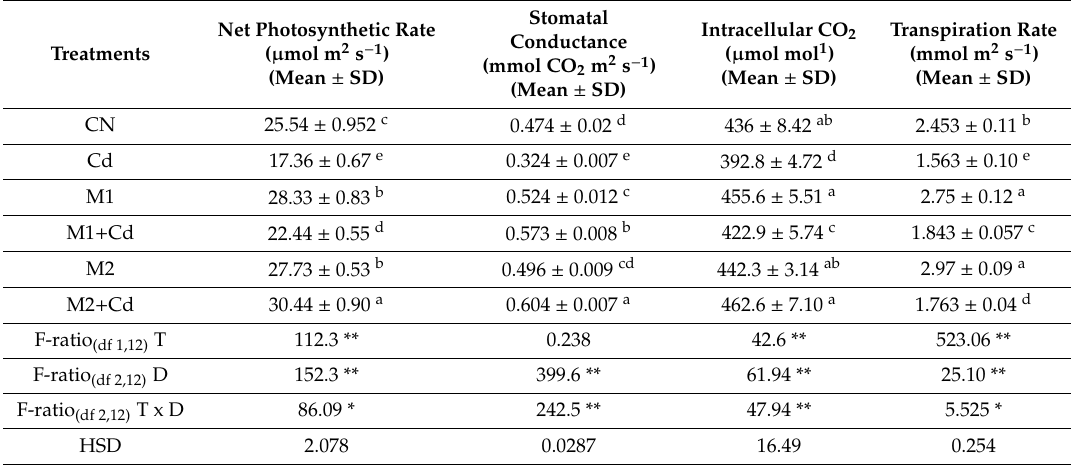
Table 1. E ff ect of Cd (0.4 mM), M1 (10 9 cells / mL), and M2 (10 9 cells / mL) and their combinations on Phenolic